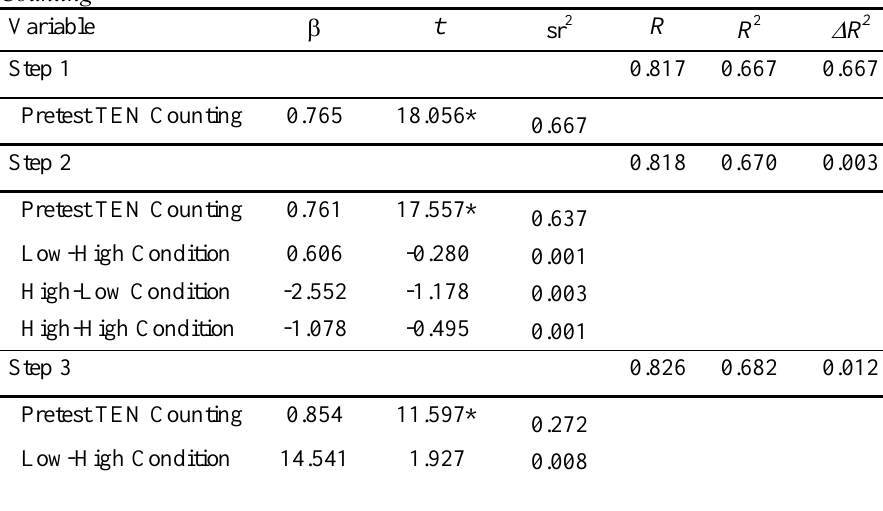
Summary of Hierarchical Regression Analysis for Variables predicting Posttest